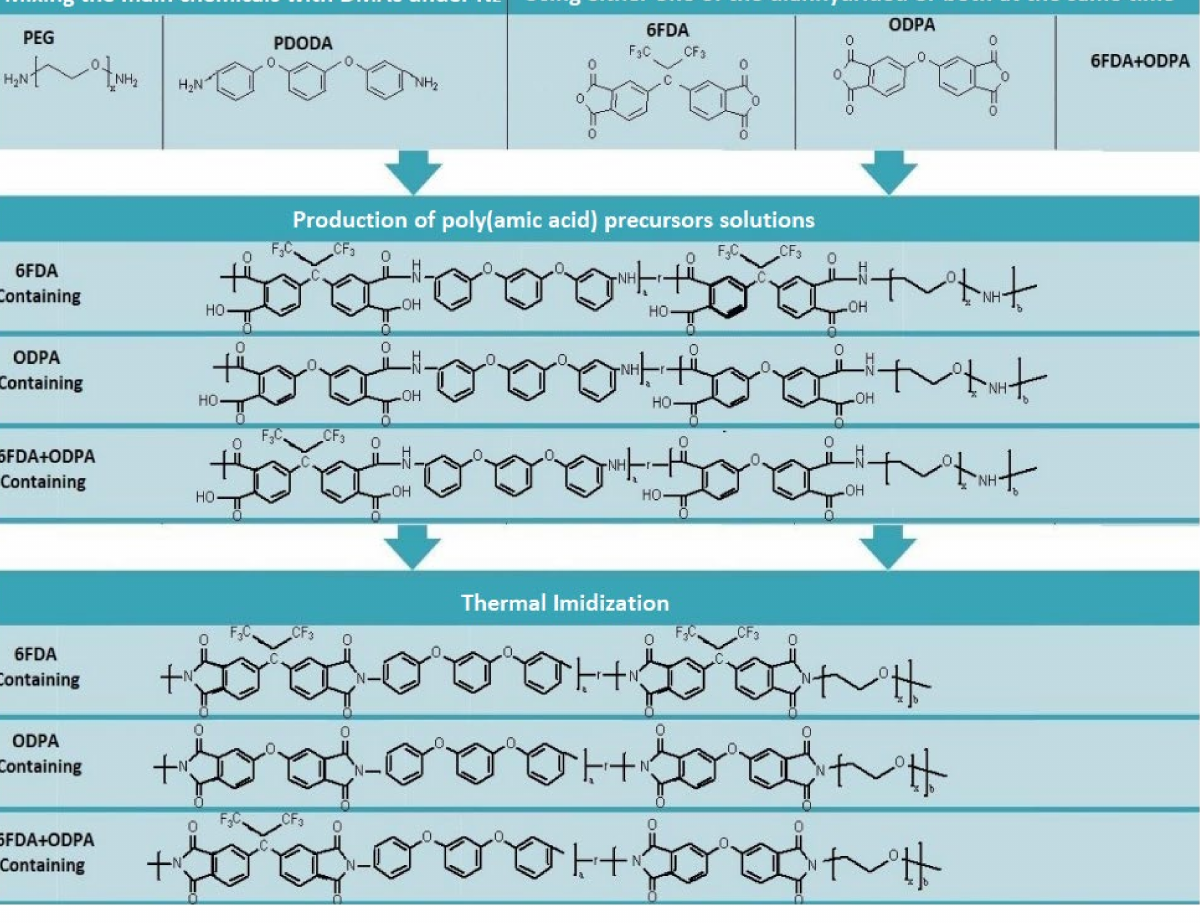
Figure 8. Schematic representation of two-step condensation polymerization and chemical structures of the synthesized